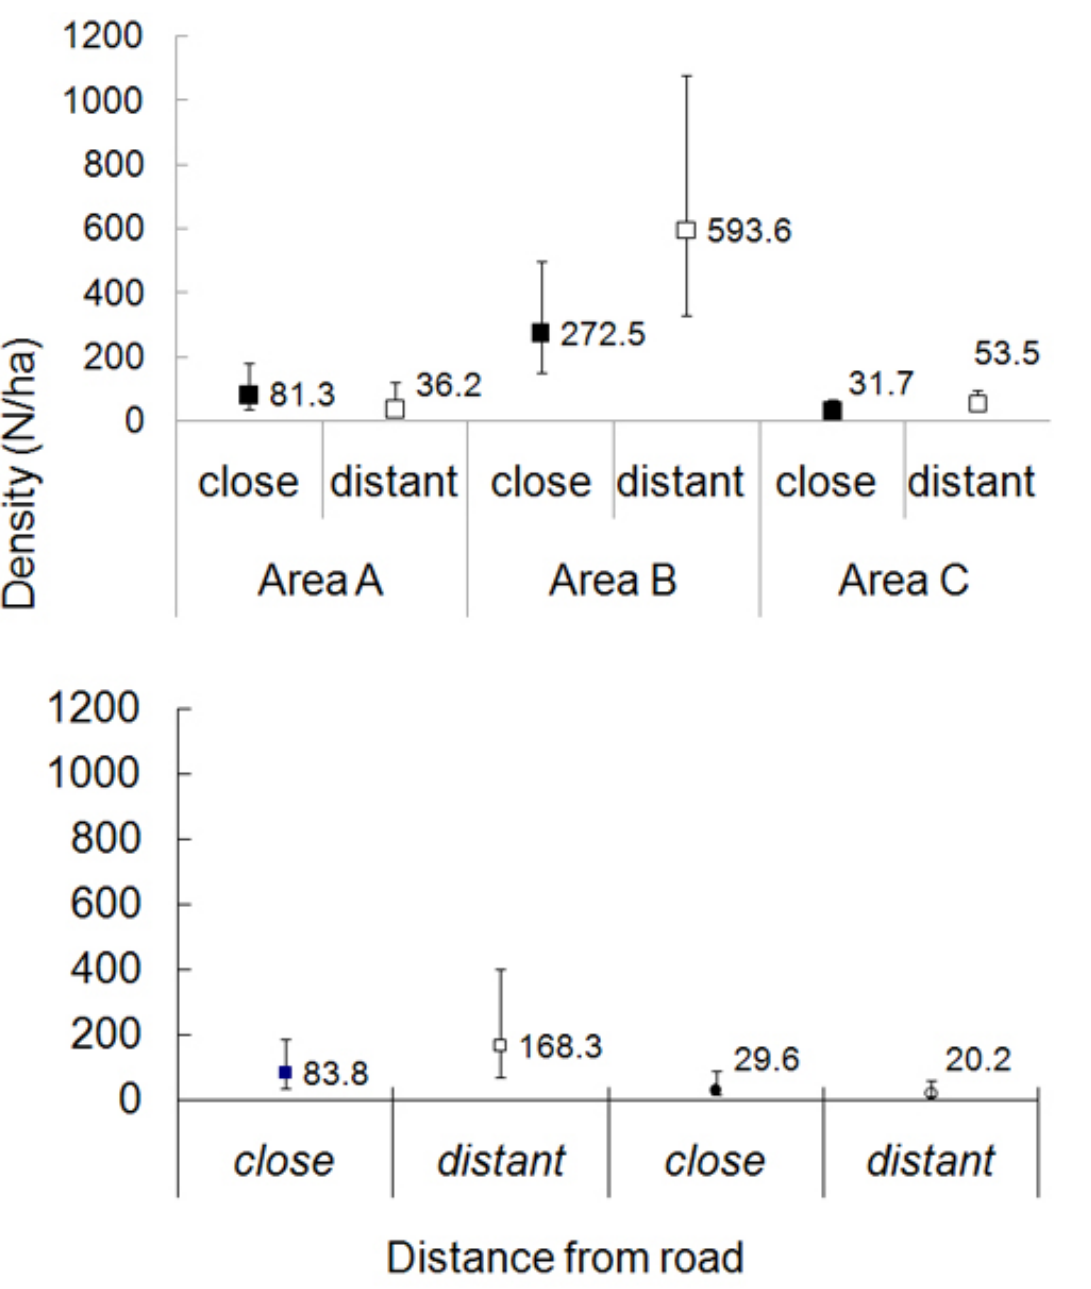
Figure 4. (a) Density estimates of small mammals (95% confidence intervals) in 2004 at different distances from the I-15 in three distinct geographic areas (A, B, C); (b) Density estimates of Peromyscus maniculatus and Perognathus parvus (95% confidence intervals) in 2004 at different distances from the I-15, southern Utah,